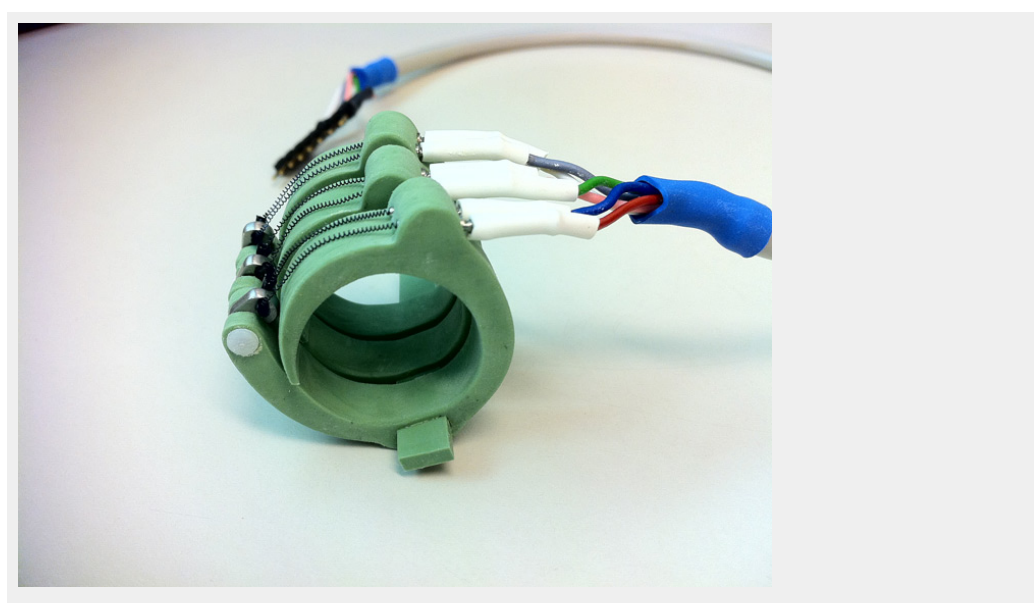
Figure 4 The urinary sphincter is made of 3 silicon rings (green part) whose diameter decreases when the nitinol fibre (black springs) is activated. The rings are placed around the urethra. Up to 5 rings could be placed to ensure the optimal control of urinary flow reducing the risk of urethra